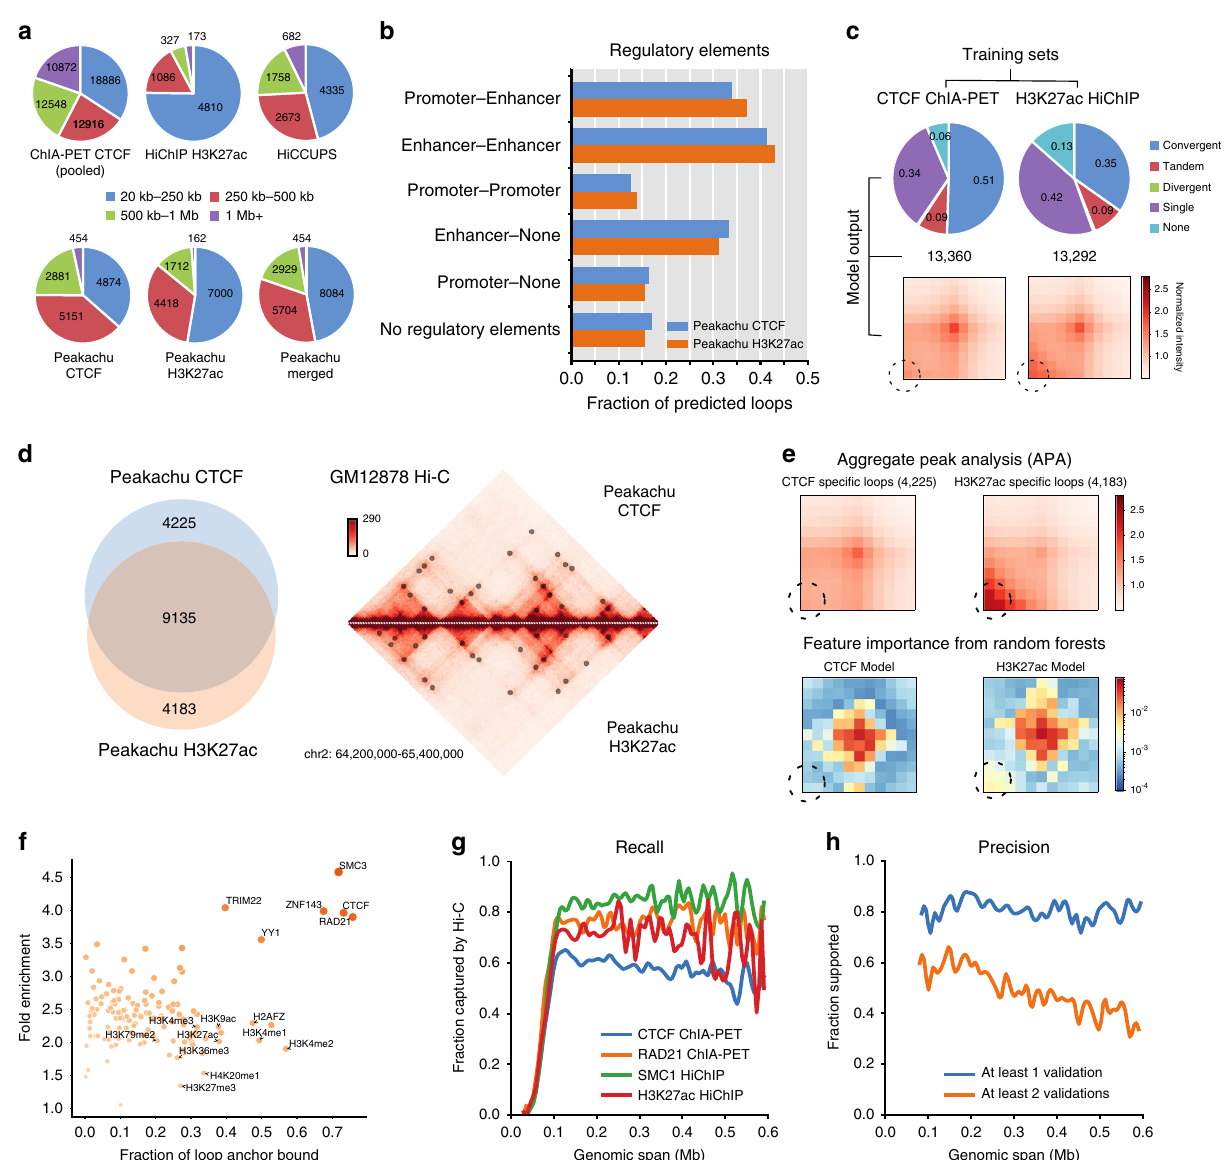
Fig. 2 Peakachu framework applied in GM12878 Hi-C. a Distance distributions of CTCF ChIA-PET, H3K27ac HiChIP, and HiCCUPS (Hi-C) interactions in GM12878 (top row). Distributions of Peakachu loops predicted from Hi-C after training with CTCF ChIA-PET or H3K27ac HiChIP data, and union of both predictions (bottom row). Interactions in CTCF ChIA-PET were fi rst pooled to remove local redundancy with the same algorithm used by Peakachu. b Proportion of predicted loops with different regulatory element combinations at anchor loci. c CTCF binding patterns and APA analysis of Peakachu predictions. d Overlap of loops predicted by Peakachu models trained with either CTCF ChIA-PET or H3K27ac HiChIP examples, and visualization of interactions predicted from both models. e Different features drive the predictions for CTCF and H3K27ac models. APA plots for loops uniquely predicted by CTCF or H3K27ac models (top row). The feature importance metric from random forests showing which pixels drive the classi fi cation most strongly (bottom row). f Fraction and enrichment of Peakachu loop anchors bound for 133 transcription factors and 10 histone modi fi cations. g Fraction of GM12878 interactions in orthogonal experiments recaptured by merged Peakachu loops. h Fraction of Peakachu predictions validated by orthogonal experiments. Source data are available in the Source Data fi